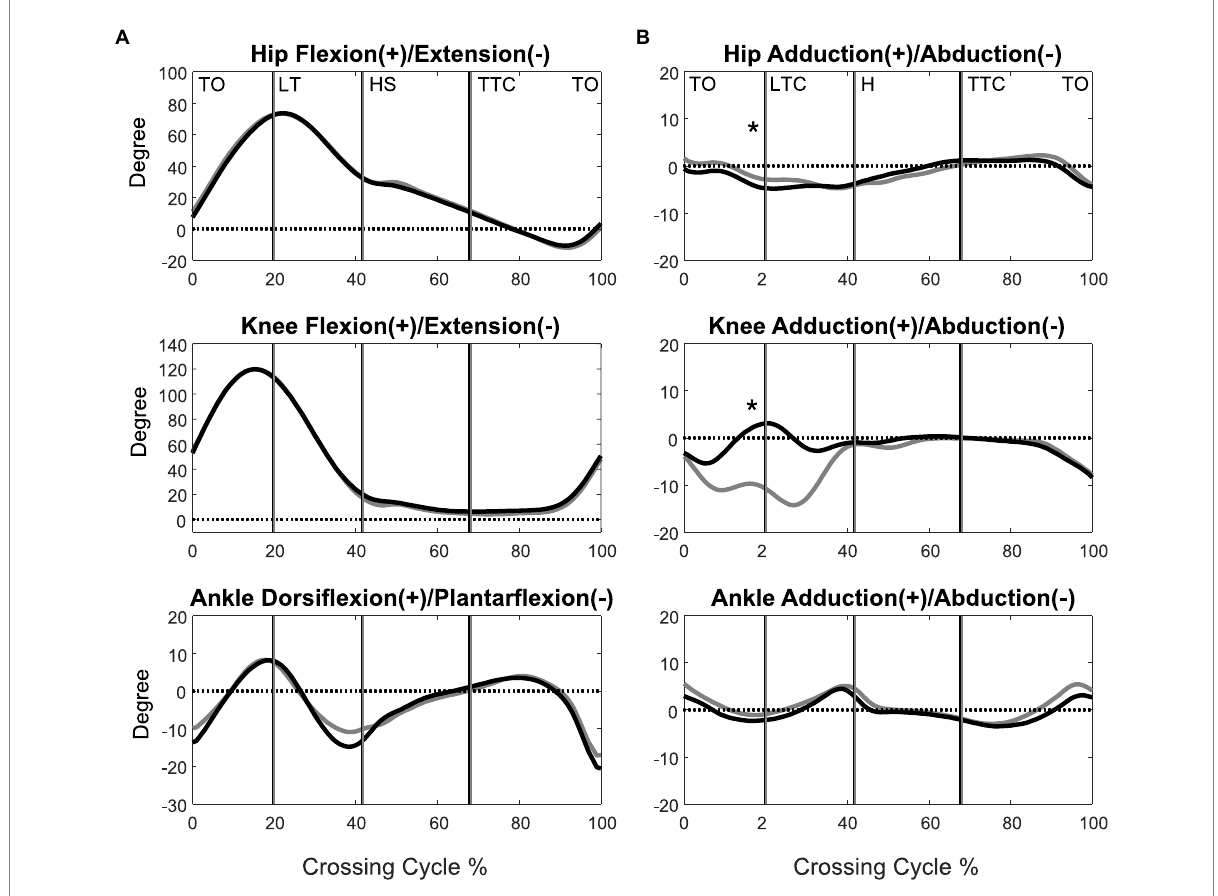
FIGURE 1 The mean curves of the angles of the hip, knee, and ankle joints of the leading limb in the sagittal (A) and frontal plane (B) for the MCI (black) and control (grey) groups when crossing obstacles of 30% of leg length. (TO, toe-off of the leading limb; LTC, leading toe above the obstacle; HS, heel-strike of the leading limb; TTC, trailing toe above the obstacle; *significant group effects for all obstacle heights, p <